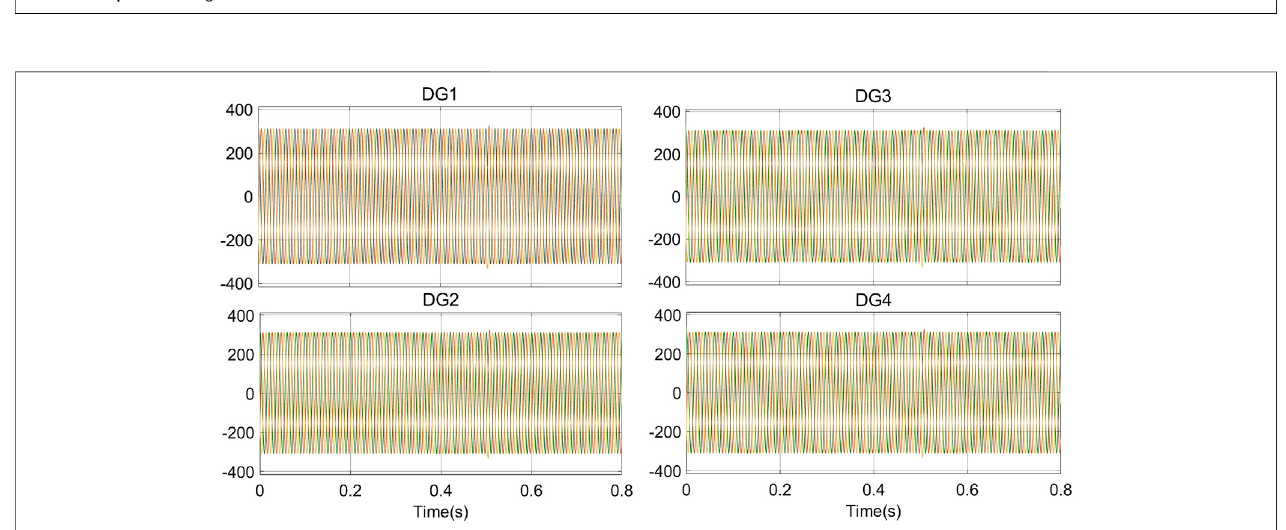
FIGURE 8 | Load voltage and current under load mutation.